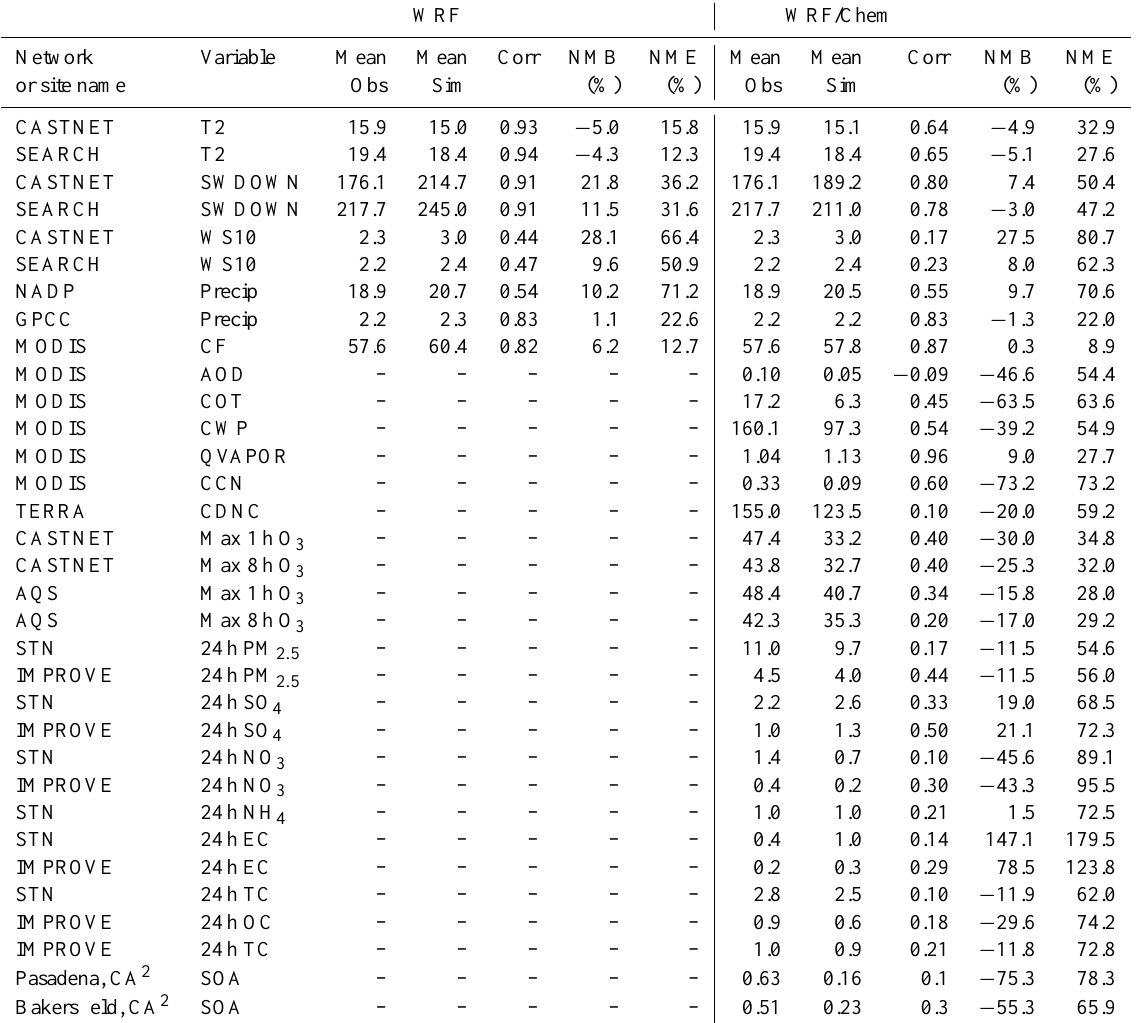
Table 1. Annual performance statistics for 2010 Predictions of WRF and WRF/Chem.